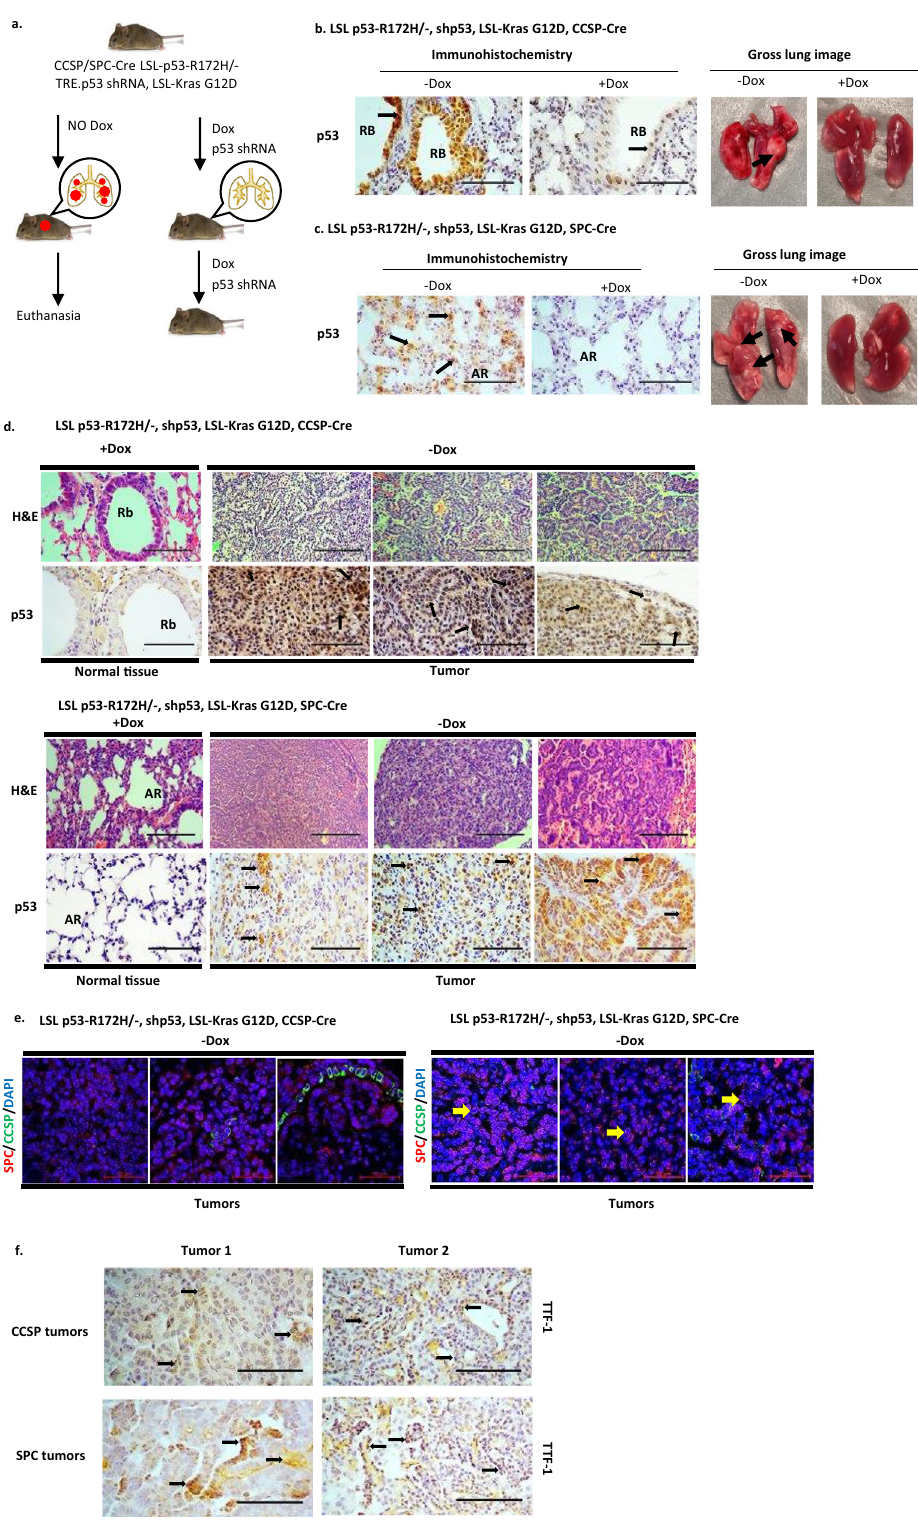
induced by GOF p53. Therefore, we tested this in the lung cancer model system by generating a conditional p53-L25Q/W26S/ R172H mouse (Supplementary Fig. 1a – d), which has lung-speci fi c expression of the mutant protein when crossed with CCSP-Cre mice 31 to remove the LSL cassette. To determine the contribution of transcriptional activation of GOF p53 in lung tumor formation, the p53 L25Q/W26S/R172H mouse model was constructed to